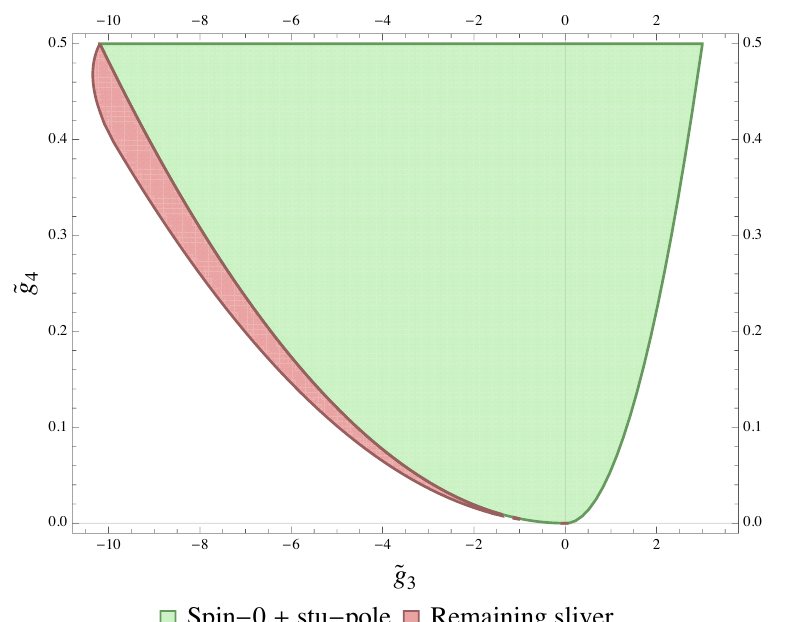
Figure 12. Remaining allowed sliver compared with the positive span of the two analytical models: M stu -pole and M spin-0 , which lie at the left and right upper kinks, respectively.